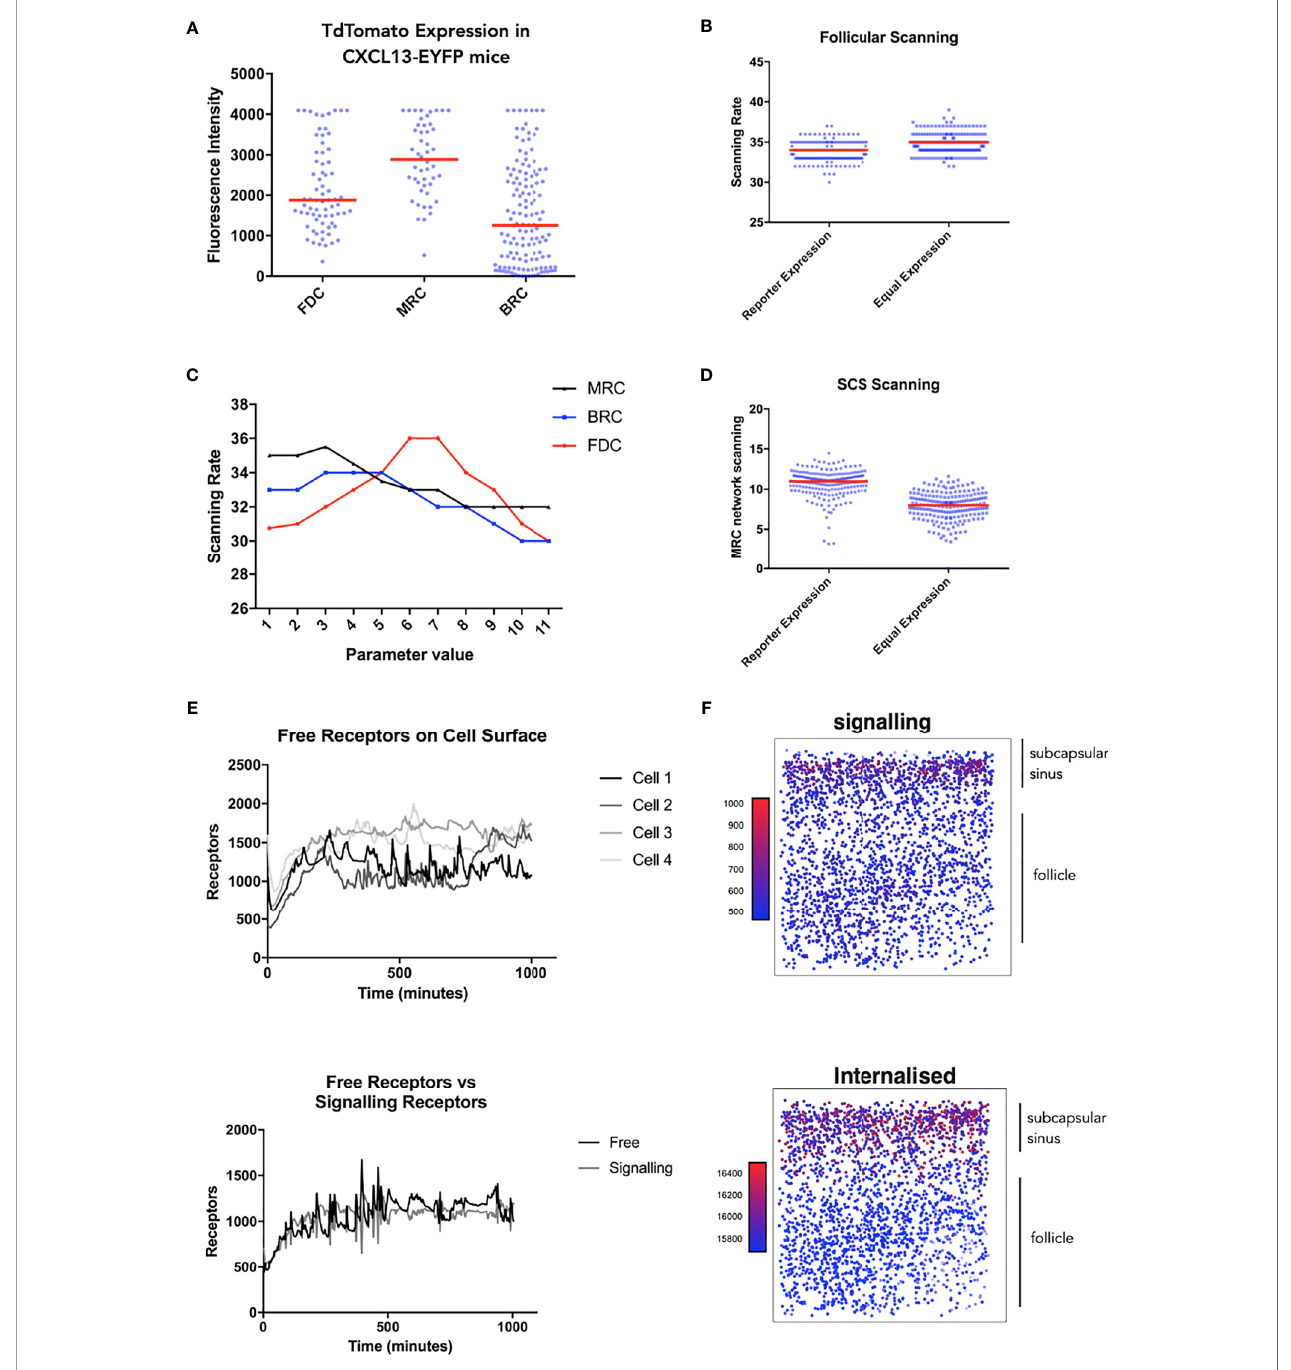
FIGURE 4 | Single cell tracking in silico to assess the spatiotemporal dynamics of CXCR5 expression and signaling. (A) Experimentally obtained in vivo CXCL13 reporter expression from different stromal cell subsets in the CXCL13-EYFP mouse. (B) In silico scanning rates for the entire follicle using equal secretion rates for all stromal cell subsets or secretion rates representative of CXCL13 reporter expression. (C) In silico scanning rates following OAT perturbations to secretion rates in different stromal cell subsets. (D) In silico scanning rates for the subcapsular sinus using equal secretion rates for all stromal cell subsets or secretion rates representative of CXCL13 reporter expression. (E) Single-cell tracking of CXCR5 expression on the cell surface. (Top) each line represents a distinct B cell within the same simulation run and (bottom) comparison of free and receptor signaling dynamics within a single cell. (F) Spatial dependence of CXCR5 signaling within the follicle. Each dot in the diagram represents the X and Y coordinates of a B cell agent in the simulator. The top of each square diagram is the subcapsular sinus. Each agent is colored by the number of receptors (as indicated by the title of each plot) with red representing high values and blue representing low